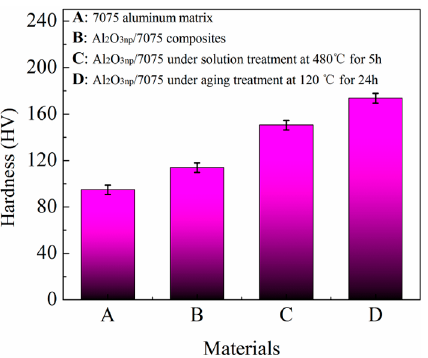
Figure 5. The hardness of 7075 aluminum matrix and Al 2 O 3np /7075 composites under different heat treatment.